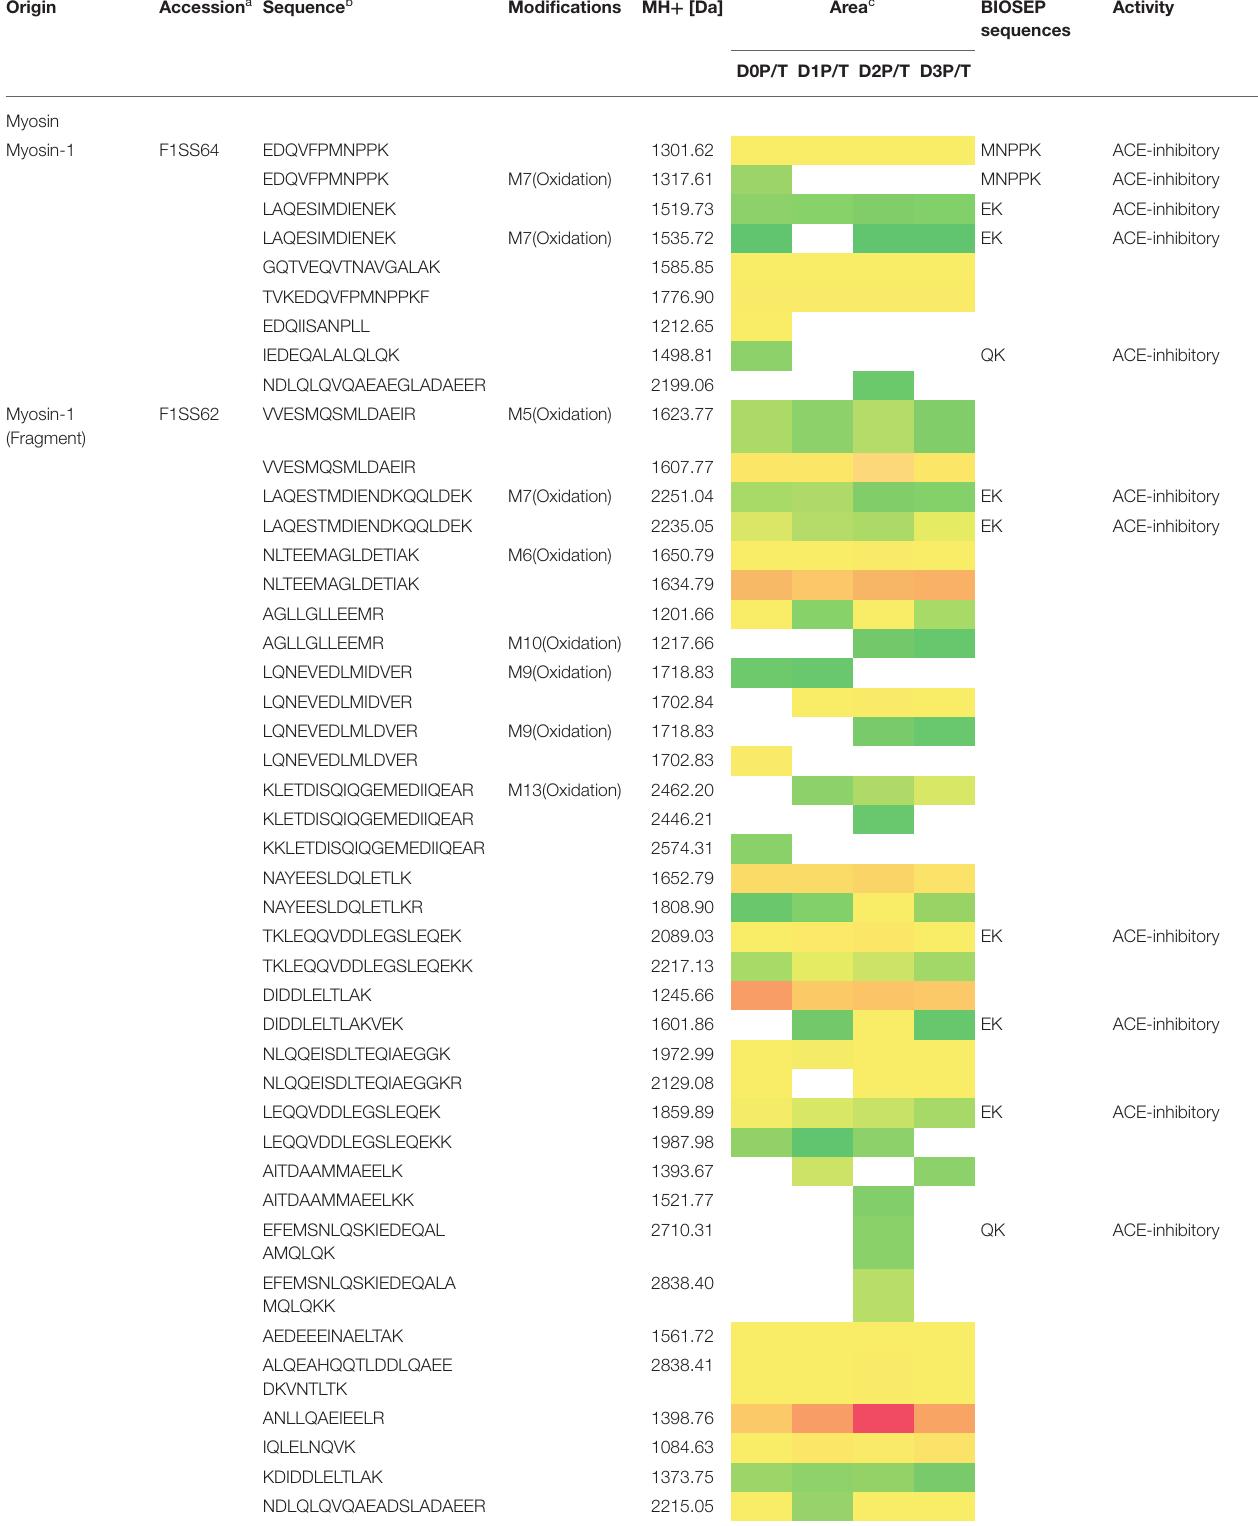
TABLE 2 | Dynamic evolution of peptides derived from myofibrillar proteins after two-step